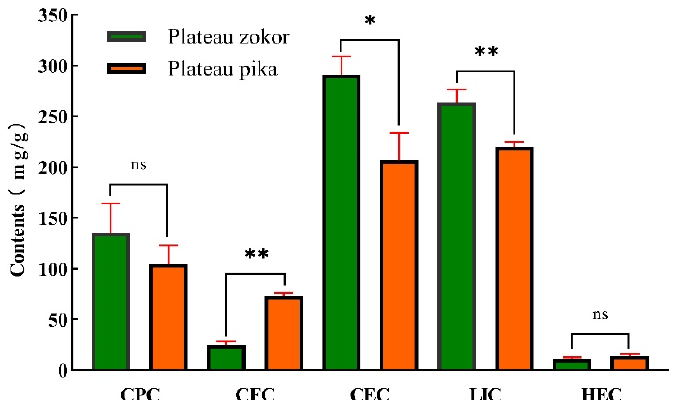
Figure 3. Differences in stomach contents between the plateau zokor and plateau pika. * indicates significant difference ( p < 0.05); ** indicates an extremely significant difference ( p < 0.01); ns indicates an insignificant difference.